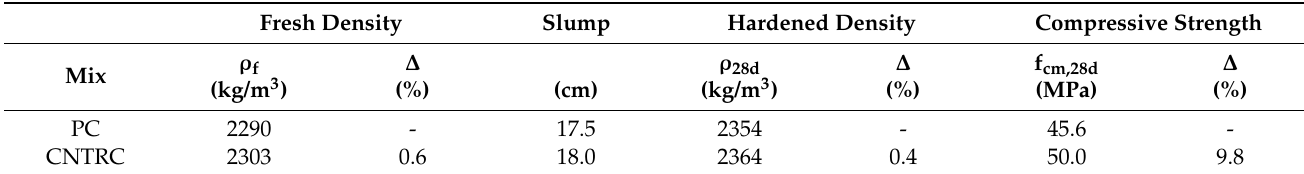
Table 4. Fresh density ( ρ f ), 28 days hardened density ( ρ 28d ), and 28 days compressive strength (f cm,28d ) of